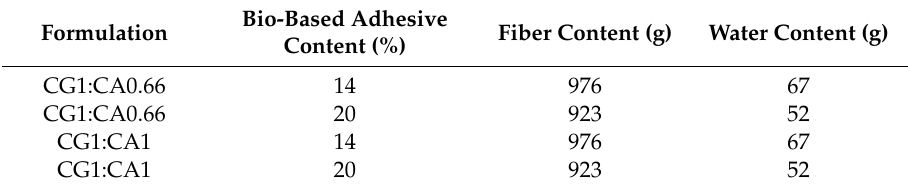
Table 2. Wood fiber insulation board manufacturing